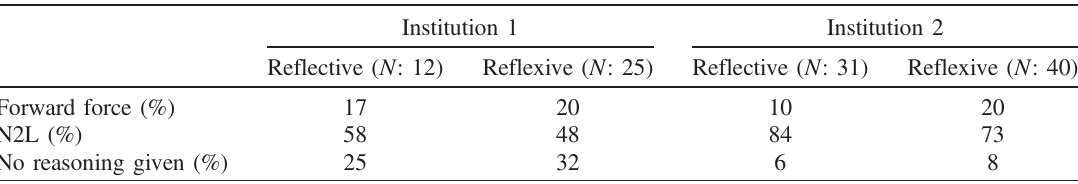
TABLE V. Reasoning given on the target question (Q3) by those students who answered the target question incorrectly on the pretest but answered correctly in the